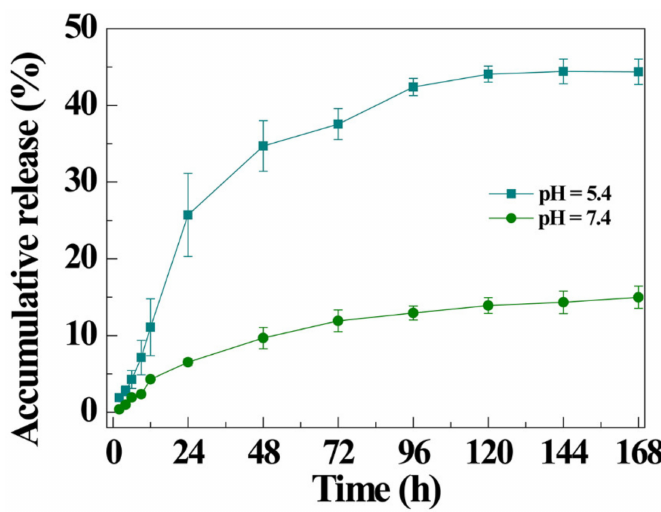
Figure 5. In vitro DOX release profile of LM-HA/DOX at 37 ◦ C under pH 5.4 and 7.4 conditions.